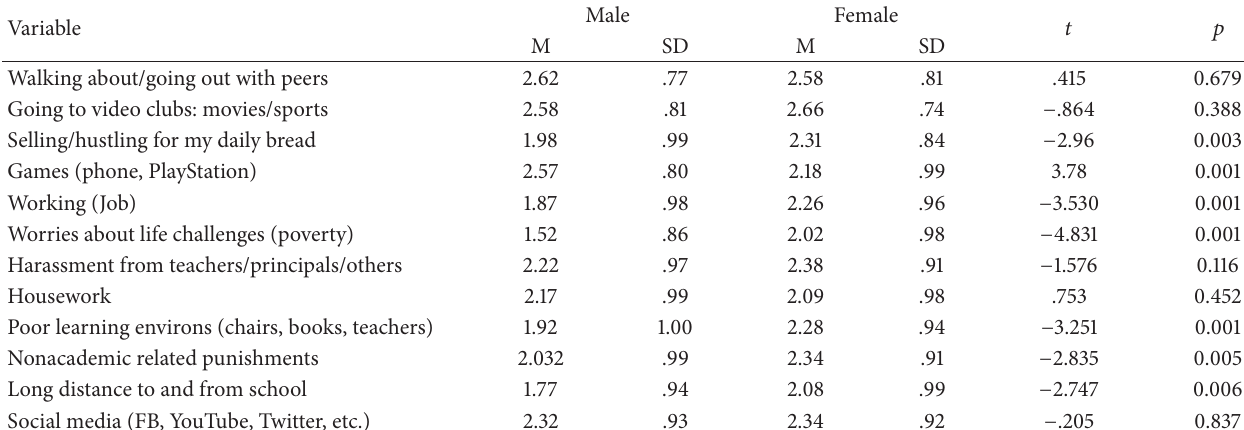
Table 5: Results for factors affecting students for gender ( 𝑛 = 323 ).